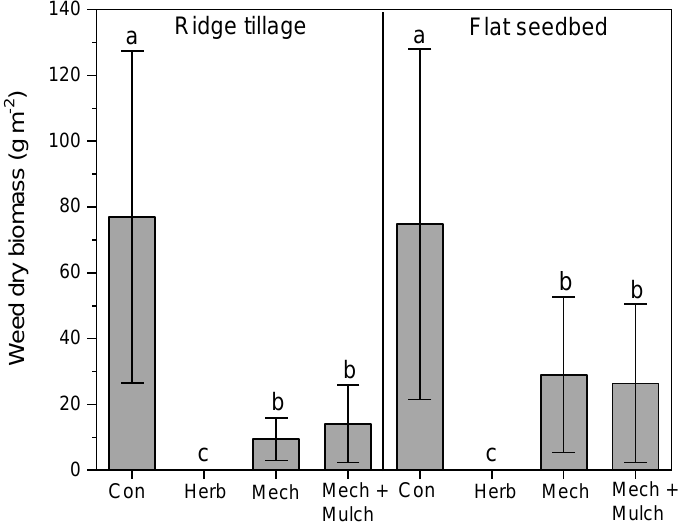
Figure 4. Average aboveground dry weed biomass after ridge tillage and conventional flat seedbed preparation and four weed control treatments (Con = untreated control; Herb = broadcast herbicide application with foramsulfuron + thiencarbazone methyl + iodosulfuron + cyprosulfamide (Safener); Mech = two rounds of hoeing and harrowing; Mech + Mulch = one round of hoeing and harrowing followed by sowing of living mulches in ridges pooled over two experiments 81 days after seeding maize at the University of Hohenheim Research Station, Germany, in 2021. Bars represent standard deviations. Means with the same letter are not significantly different according to Tukey’s HSD test at p ≤